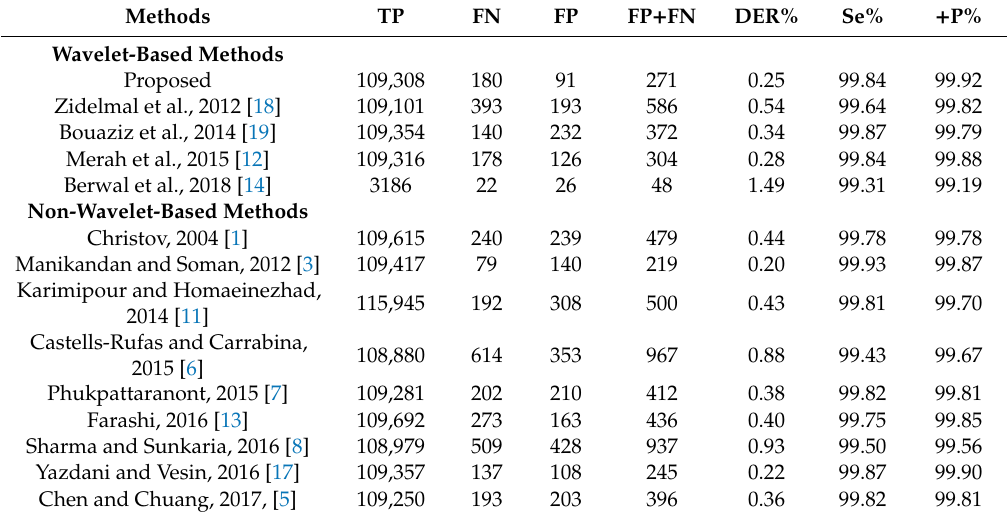
Table 2. Performance comparison of the proposed QRS peak detection system with the previous